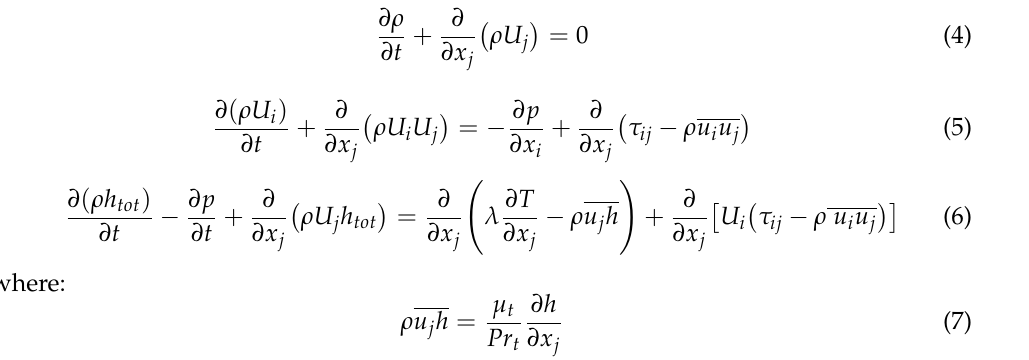
Figure 4. Developed measurement system for flow-acoustics studies.